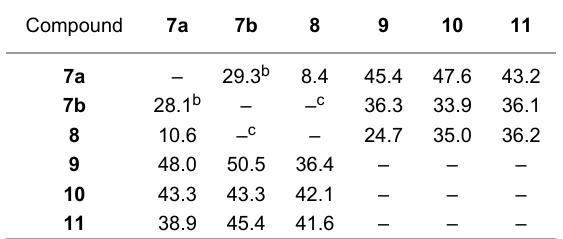
a The energies are quoted relative to local energy minima at the poten- tial hypersurface which are reached as endpoints of the IRC calcula- tions. Upper number triangle: reaction from lower to higher compound number; lower number triangle: backward reaction. b Uncatalyzed rota- tion around C–N bond. c Structure not possible for geometric